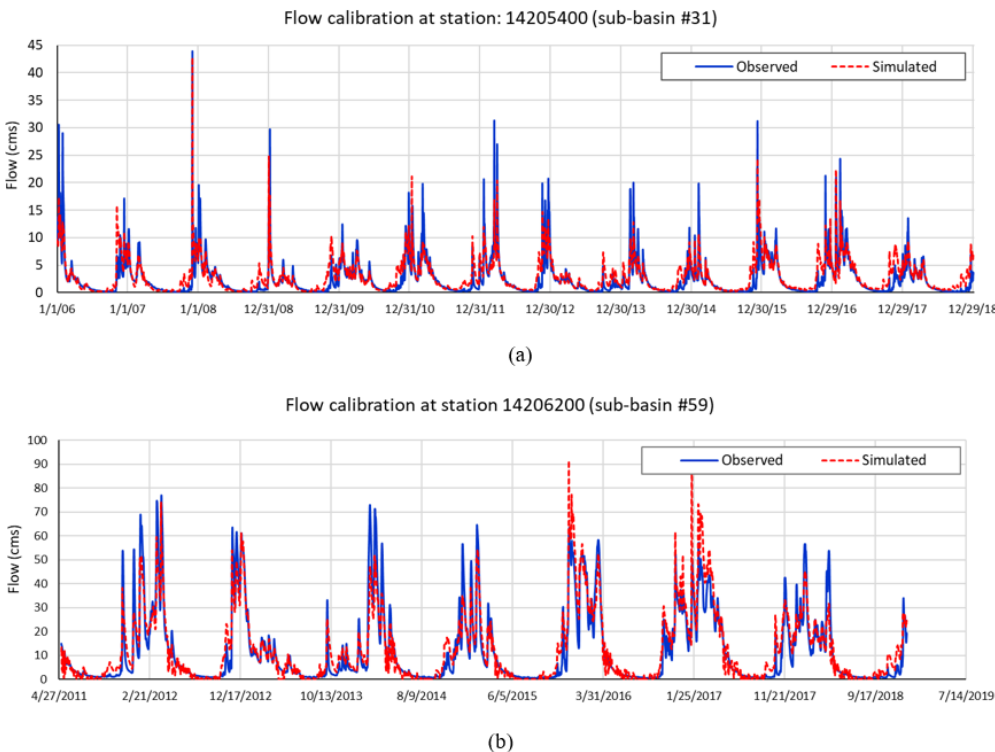
Figure 2. (a) Flow calibration at station USGS-14205400 (outlet of sub-basin #31) and (b) station 14206200 (outlet of sub-basin #59). Table 1. Calibration coefficients for the linear, original Ficklin et al., and modified Ficklin et al. stream temperature models. Calibration site Modified Ficklin et